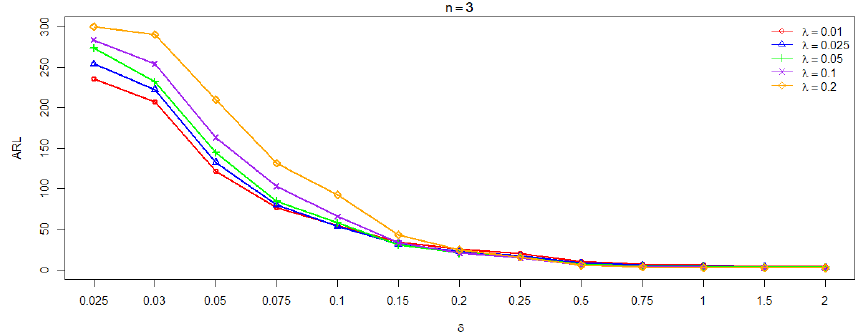
Figure 2. Effect of 𝜆 on OOC ARL performance of the proposed chart under 𝑚 = 3 and 𝑛 = 3 .